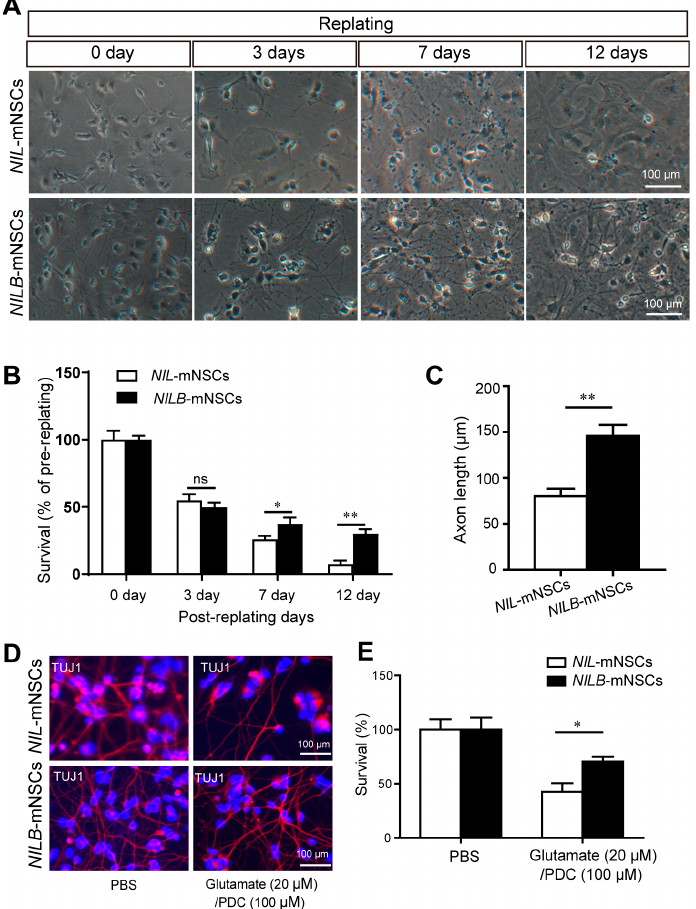
Figure 3. Bcl − xL overexpression promotes the survival of induced motor neurons. ( A ) Bright field for the surviving neurons pre − /post − replating, scale bar = 100 μ m. ( B ) Quantitative analysis of the survival rates. Error bars represent SEM; n = 3 separate differentiation experiments each using the genetically modified NIL − mNSCs and NILB − mNSCs; two − tailed Student’s t − test; ns, not significant; * p < 0.05; ** p < 0.01. ( C ) Quantitative analysis of the axon length. Error bars represent SEM; n = 3 separate differentiation experiments each using the genetically modified NIL − mNSCs and NILB − mNSCs; two − tailed Student’s t − test; ** p < 0.01. ( D ) Immunostaining for the survival neurons with or without glutamate treatment, scale bar = 100 μ m. ( E ) Quantitative analysis of the survival rates of induced motor neurons. Error bars represent SEM; n = 3 separate differentiation experiments each using the genetically modified NIL − mNSCs and NILB − mNSCs; two − tailed Student’s t − test; * p < 0.05.